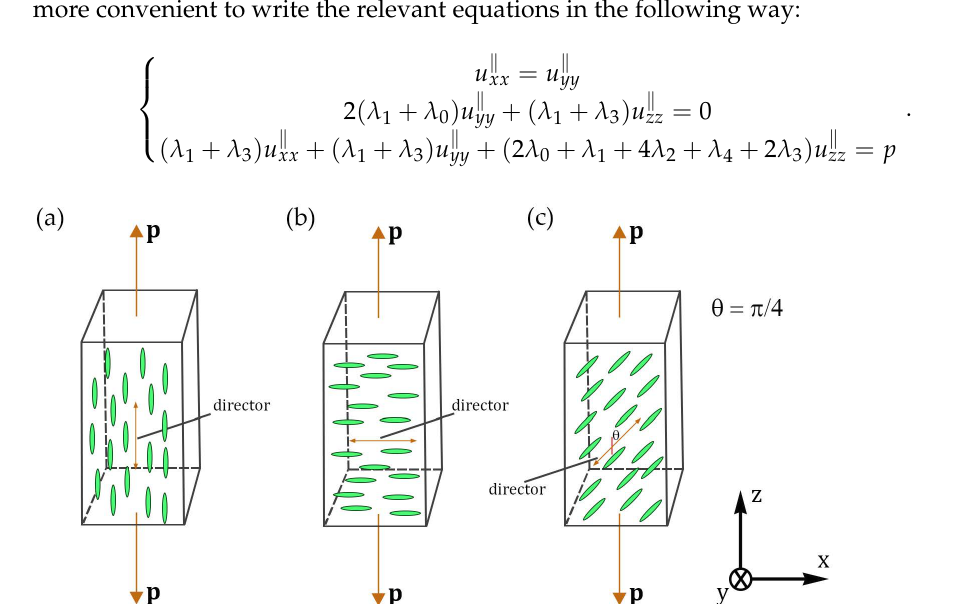
Figure 1. A schematic depiction of three experiments. ( a ) The forces are applied along the z -axis parallel to the nematic director. ( b ) The forces are applied along the z -axis perpendicular to the nematic director. ( c ) The NLC director forms an angle of 45 ◦ with the z -axis (loading direction). The force per unit area is denoted by p